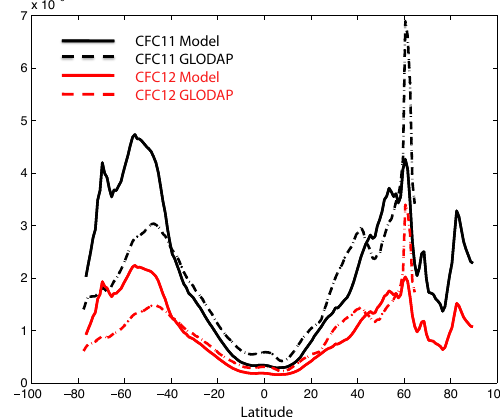
Fig. 8. Zonal mean inventories of CFC11 (black) and CFC12 (red) in molm − 2